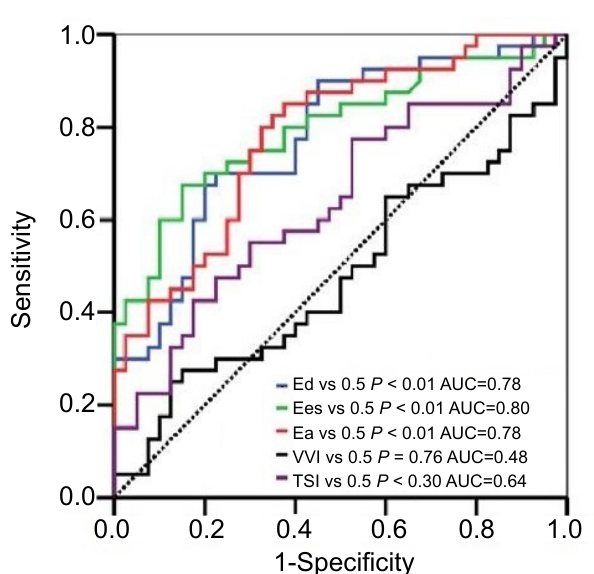
Figure 4 The exercise-induced changes of Ed, Ees, Ea, VVI and TSI were analyzed by receiver operating characteristic curve. There was no significant difference in VVI after exercise compared